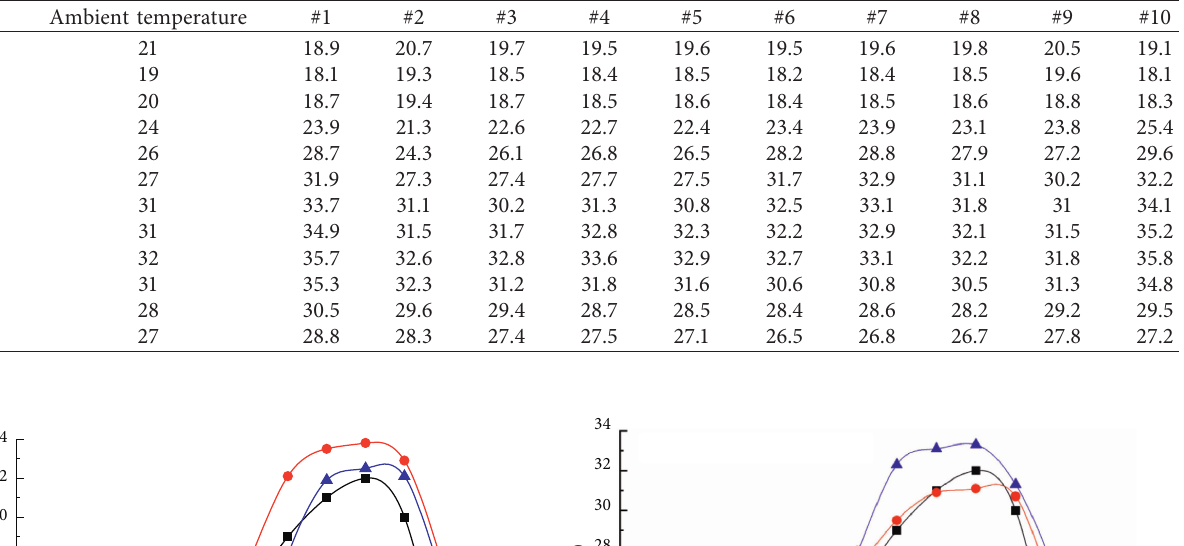
Table 3: Temperature data measured on June 11, 2021 (unit: °